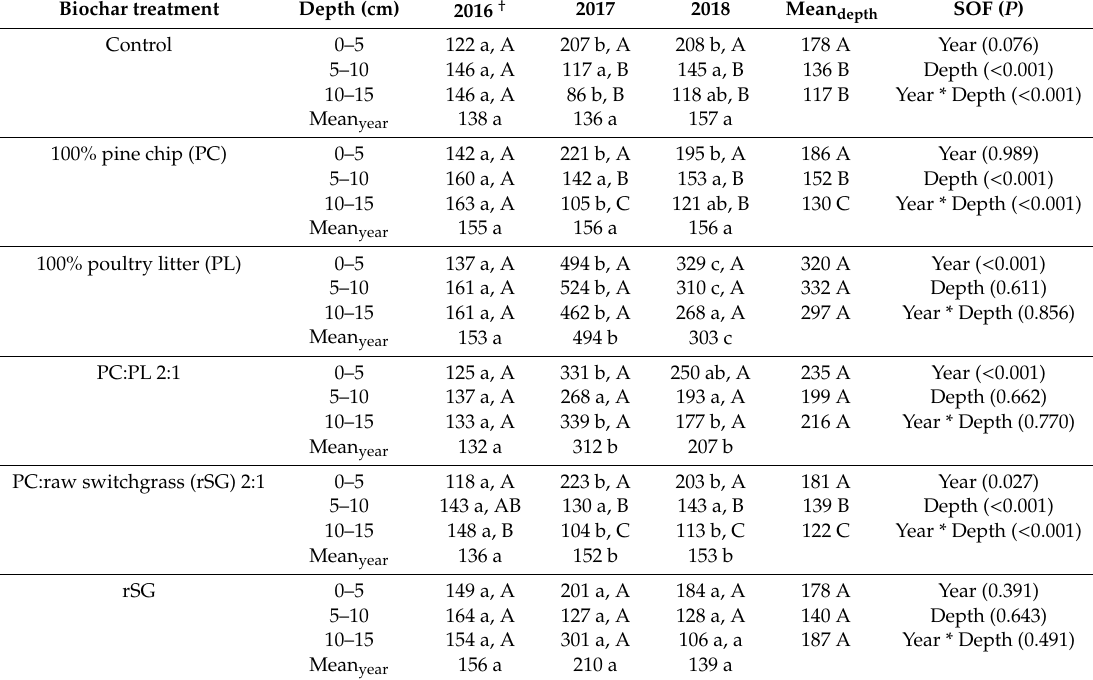
Table 10. Mean Mehlich 1 K (kg / ha) contents by soil depth per year of study (SOV = source of variation, P value in